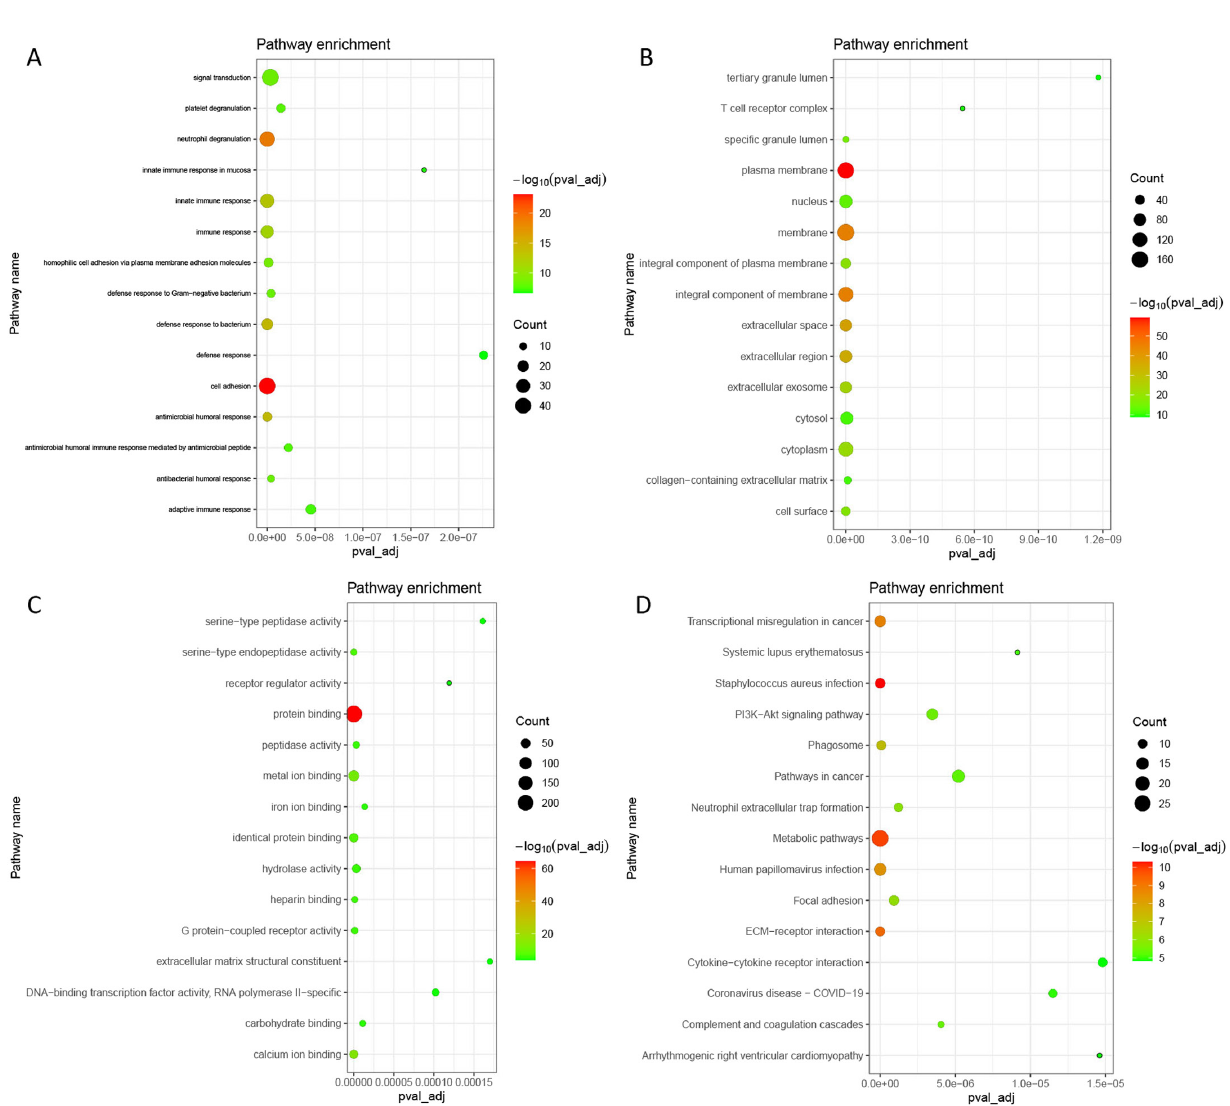
Figure 2. Significantly enriched GO terms and KEGG pathways of DEmRNAs. (A) BP, biological process; (B) CC, cellular component; (C) MF, molecular function; and (D) KEGG pathways. DE, differentially